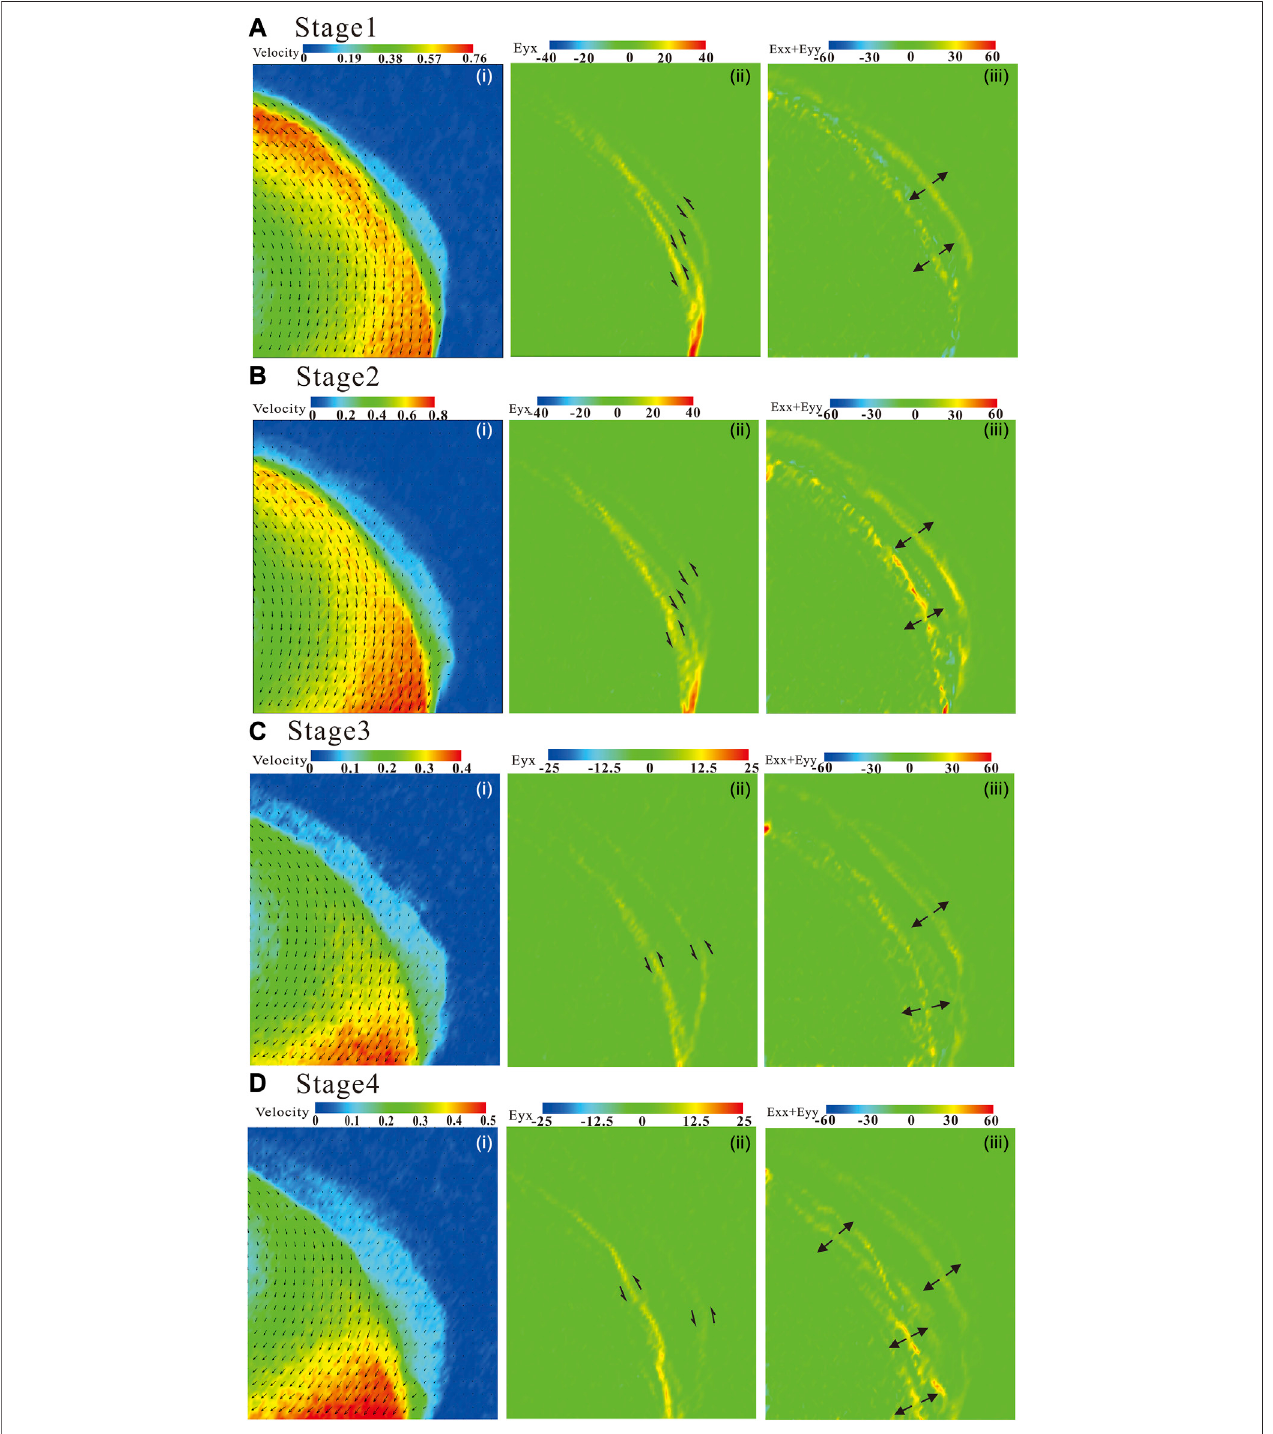
FIGURE 7 | PIV results for stages 1 (A) , 2 (B) , 3 (C) , and 4 (D) . The four panels in (A – D) represent (i) the calculated velocity, (ii) the horizontal shear strain rate component, and (iii) the area strain rate component.